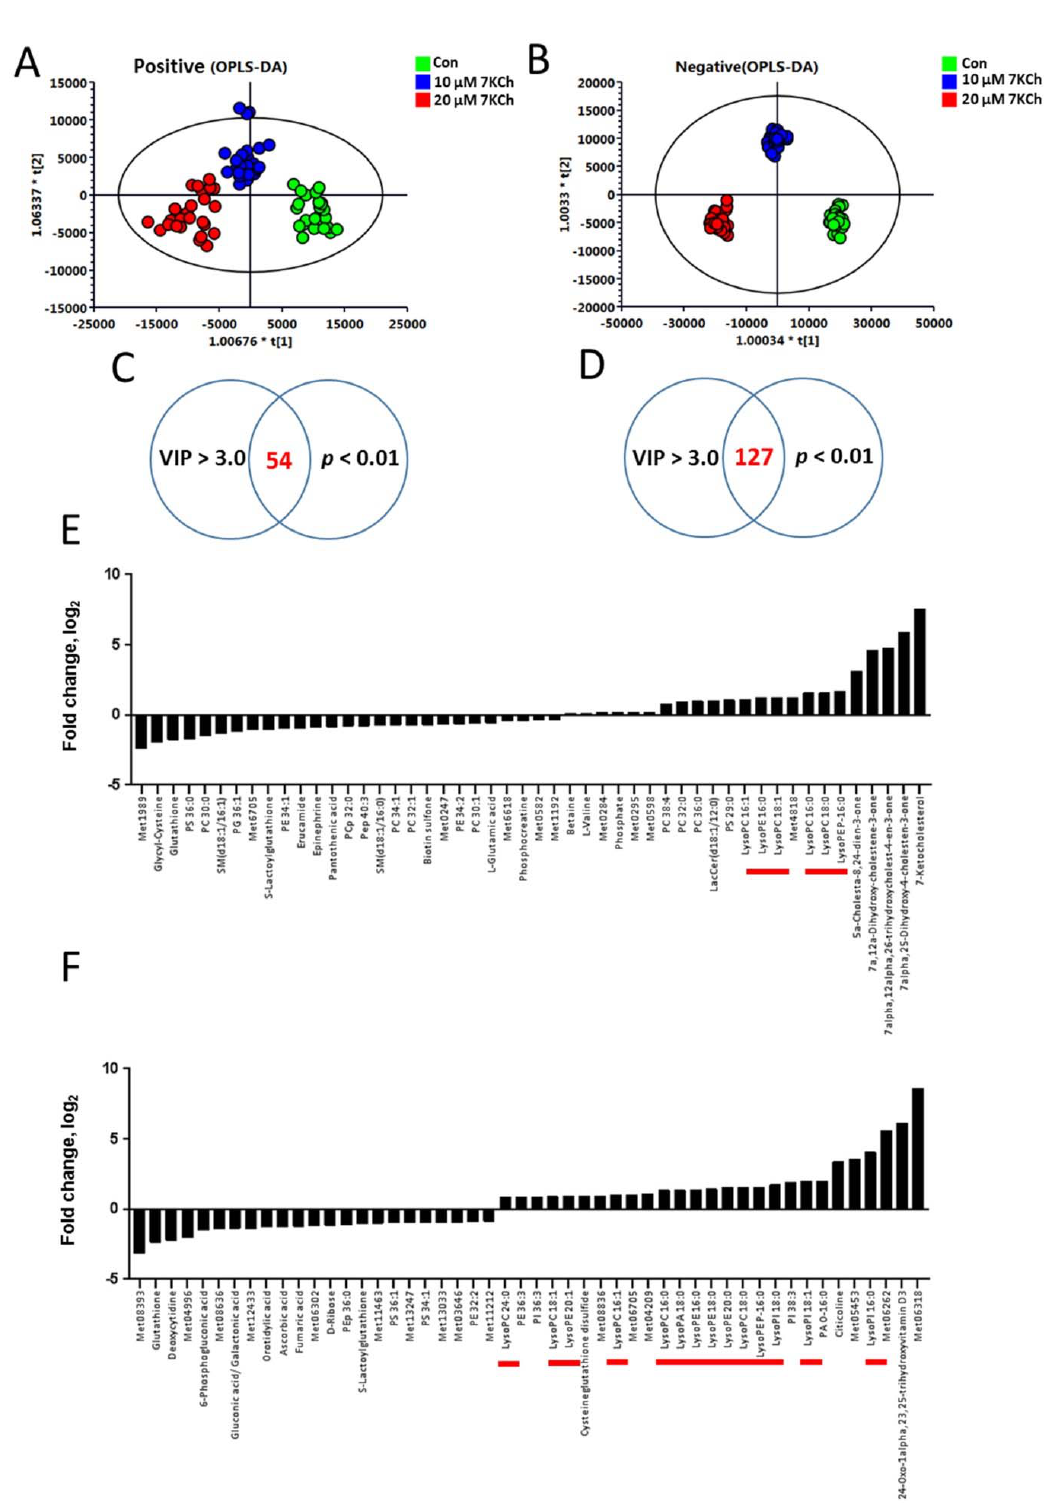
Figure 2. Changes in global metabolism in 7KCh-treated HL-1 cells. For global metabolomic analysis, HL-1 cells were untreated (Con) or treated with the indicated concentrations (10, 20 µ M) of 7KCh for 24 h, and harvested for subsequent analyses by LC-MS and LC-MS/MS in ESI-positive ( A , C , E ) and ESI-negative ( B , D , F ) modes. The corresponding OPLS-DA score plots are shown ( A , B ). Significantly different metabolites between 7KCh-treated and control cells were selected with VIP score > 3 and p value < 0.01. The log 2 fold changes in the abundance of metabolites differentially abundant in cells treated with 20 µ M 7KCh versus Con cells (i.e., the log 2 of the ratio of the abundance of a metabolite in 7KCh group to that of Con group) are plotted ( E , F ). The lysophospholipids are highlighted by the red